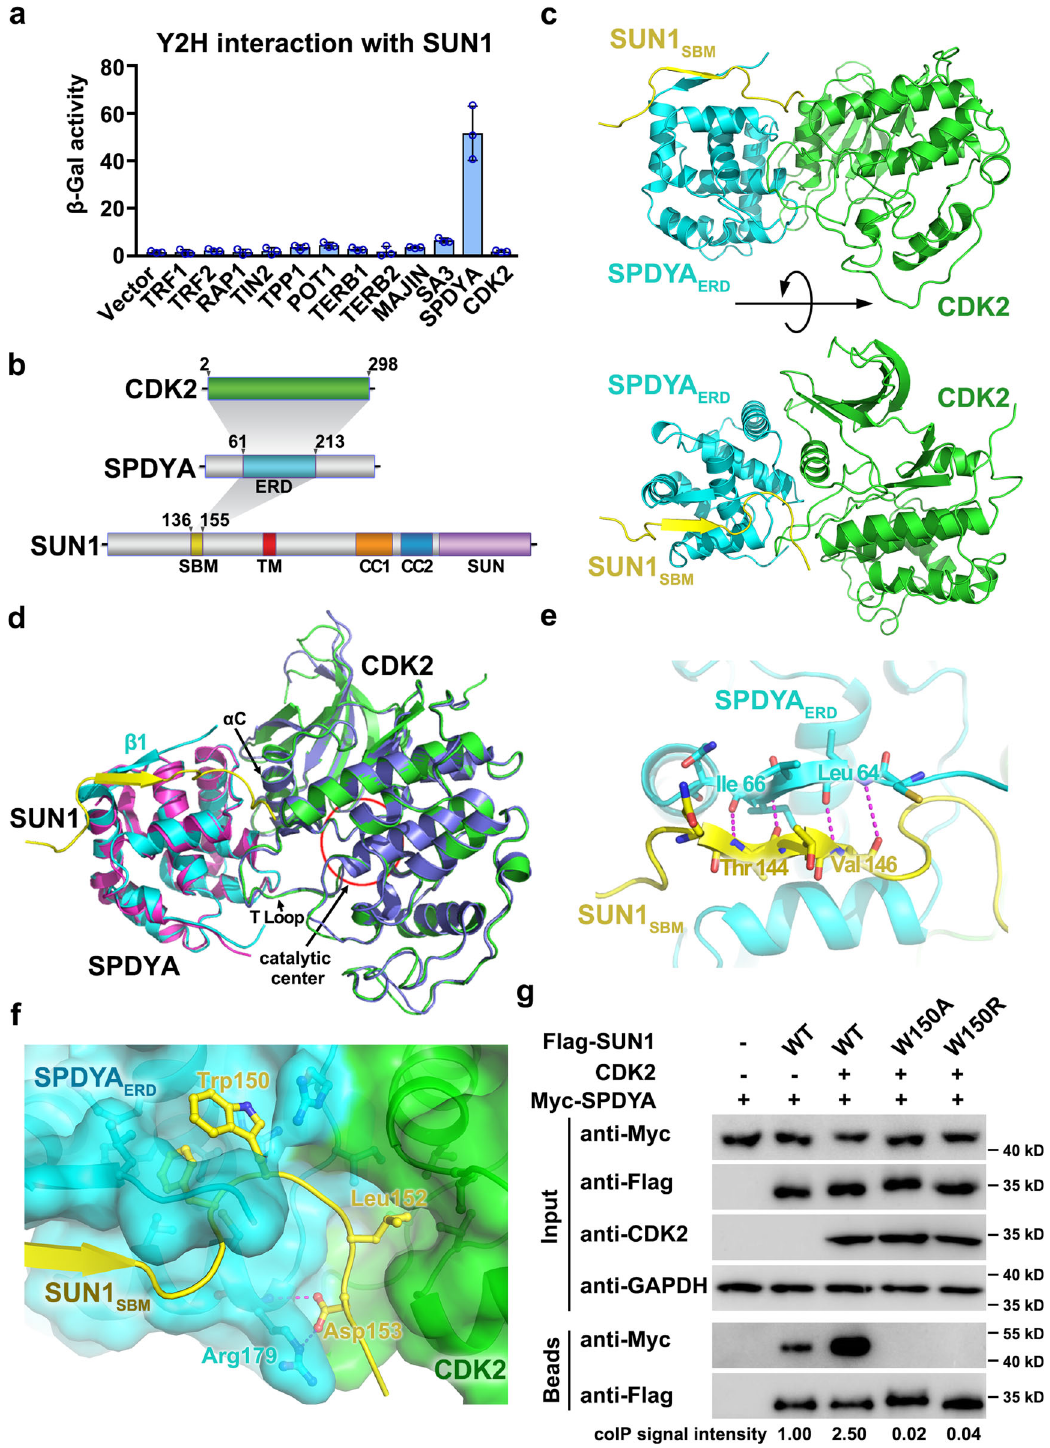
(Fig. 1d) 21 . In both structures, CDK2 is stabilized in an active con fi guration through an interface involving the activation loop (T-Loop) and the α C helix of CDK2 and one side of the SPDYA Ringo domain